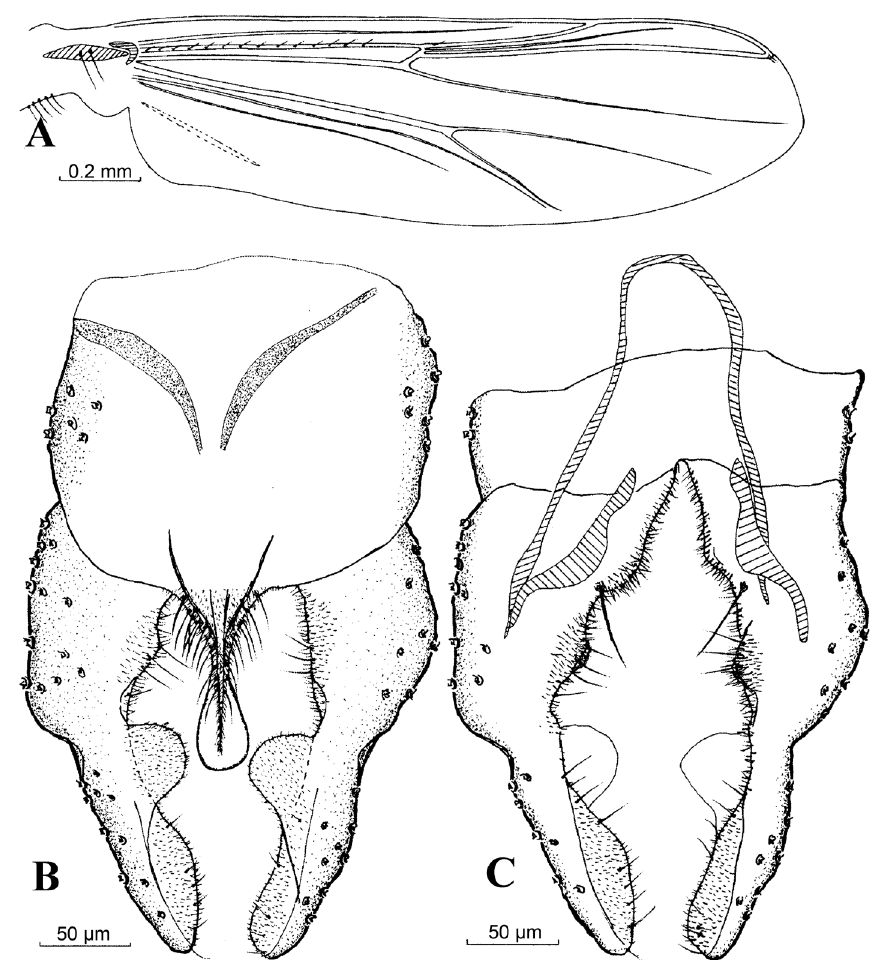
Figures 9. Harnischia turgidula . A Wing; Hypopygium: B (dorsal) C (ventral). Sweep net, Wang; 1 ♂ , Guangxi Province, Longsheng, 26.05.1990, Wang; 1 ♂ , Yunnan Province, Dali City, Yinqiao Town, Elevation 2000 m, 21.05.1996, Water net,